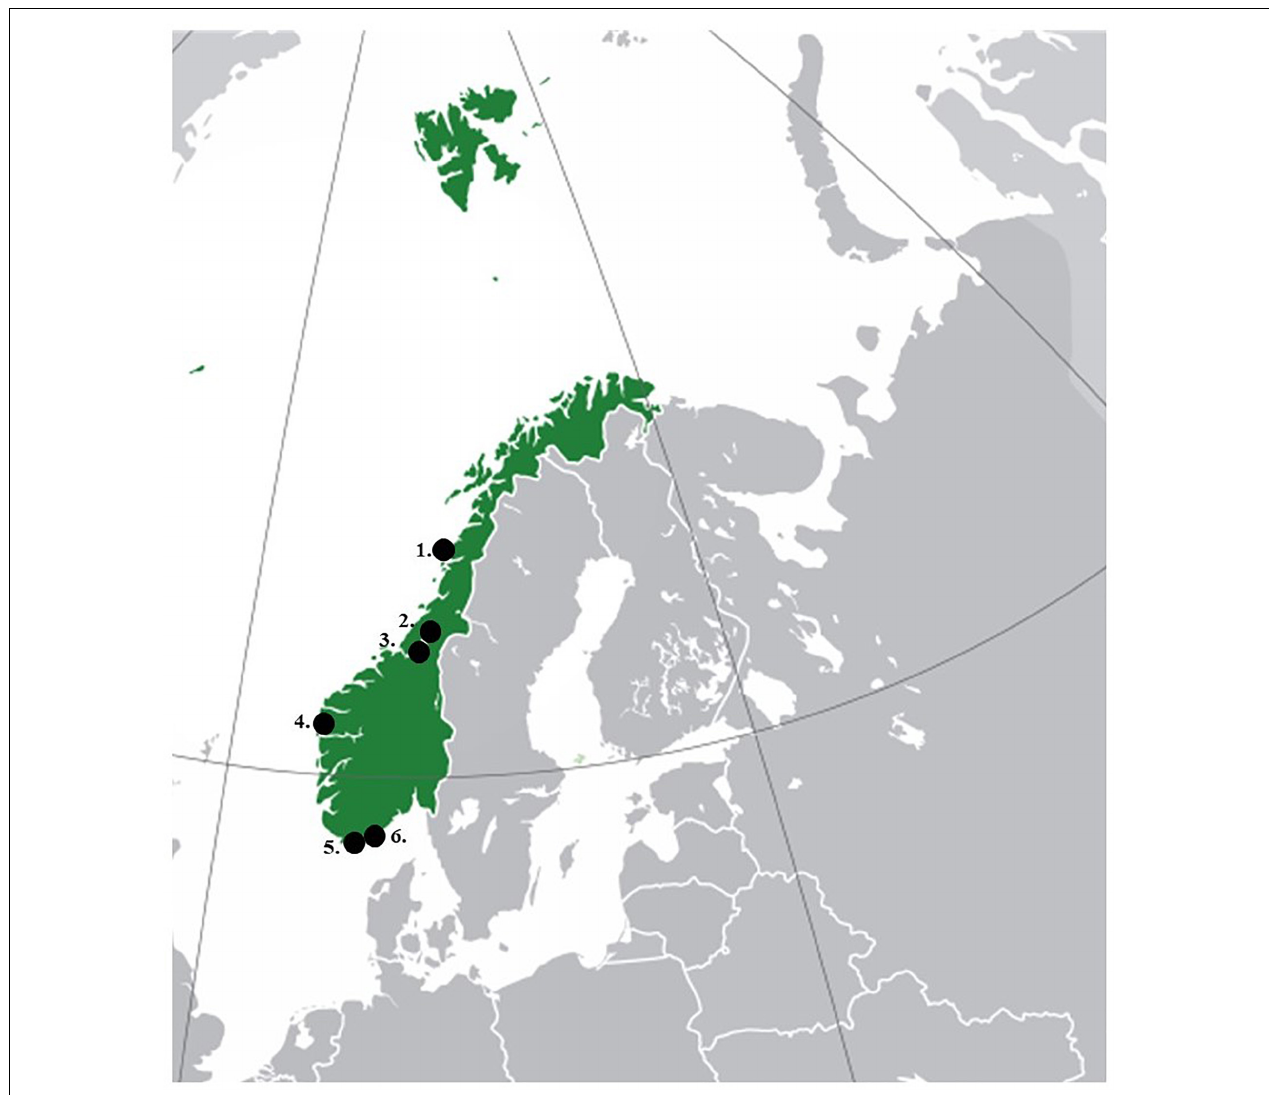
FIGURE 1 | Study area with black dots indicating the locations of the participating diving